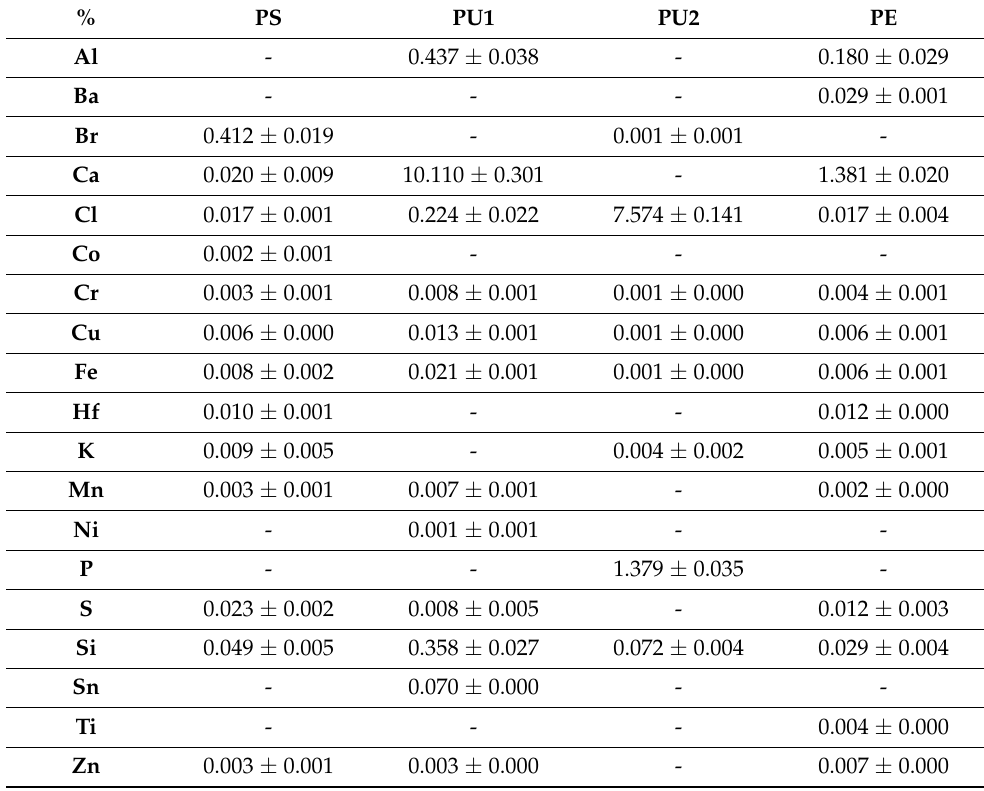
Table 3. The concentrations of elements measured in plastics samples by means of EDXRF ( ± SD; n =